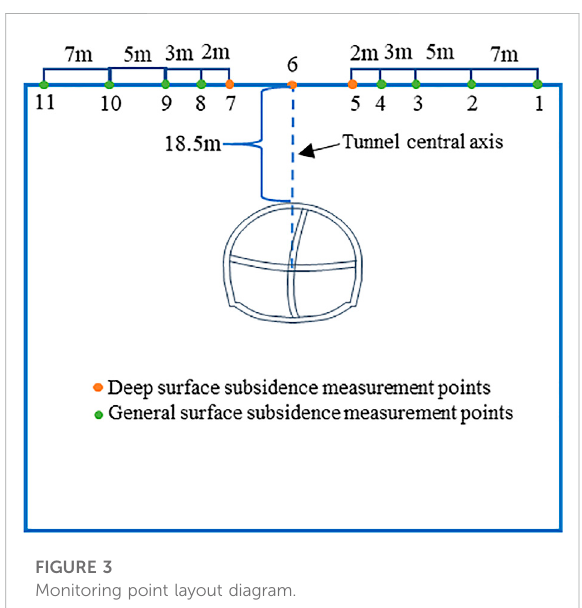
FIGURE 3 Monitoring point layout